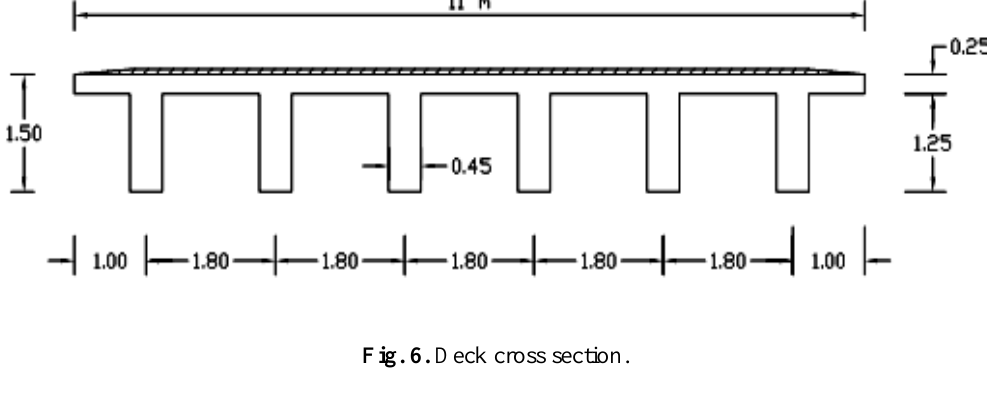
Fig. 6. Deck cross section.